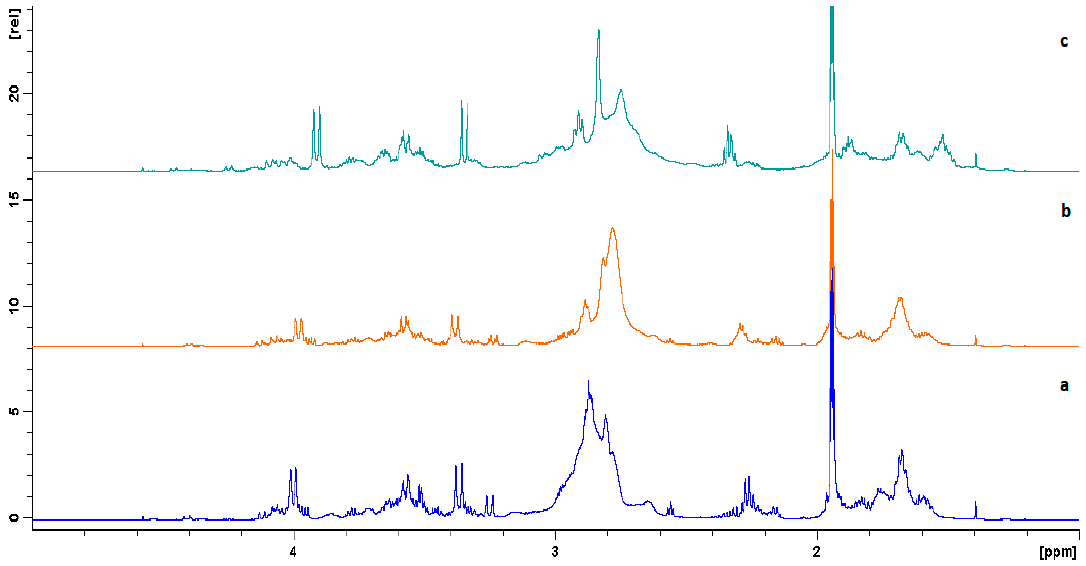
Scheme 5. Possible structure of Ag 2 L 2+ complex .